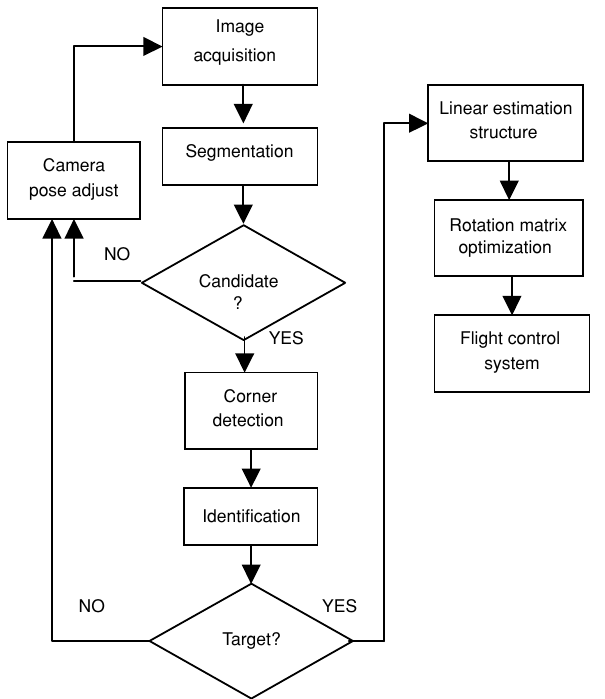
Figure 1 Pose estimation algorithm in autonomous landing.